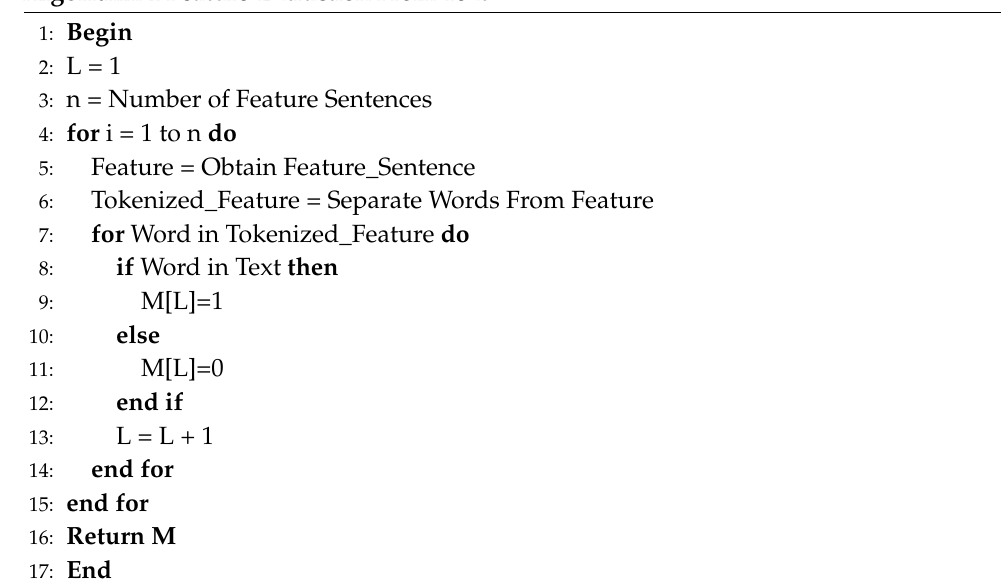
Algorithm 1 Feature-Extraction From Text